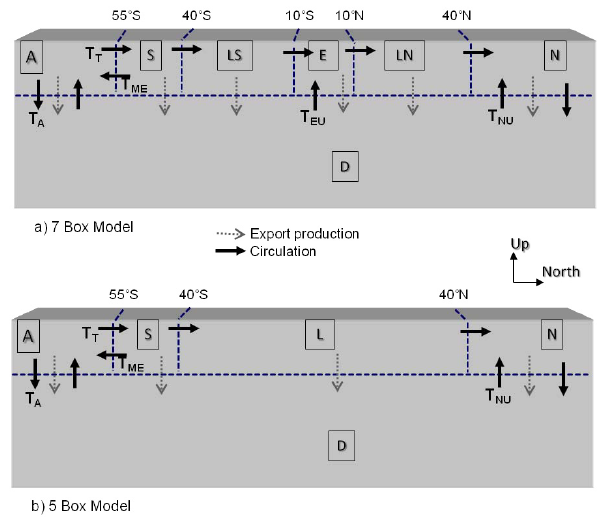
Fig. 1. The control model consists of 7 upper boxes above 500m and one deep box (a) . Export production is denoted by the dotted arrows and is the product of the nutrients concentration and a nu- trient utilization rate that varies for each surface box (see text for details). The flow of water between the boxes has five dimensions of freedom and we have labelled the flux as they are used in the equations and figures. The unlabeled fluxes are derived from the prescribed fluxes and conservation of mass. A second model is pre- sented in which the equatorial region has been integrated into the low latitude boxes (b)